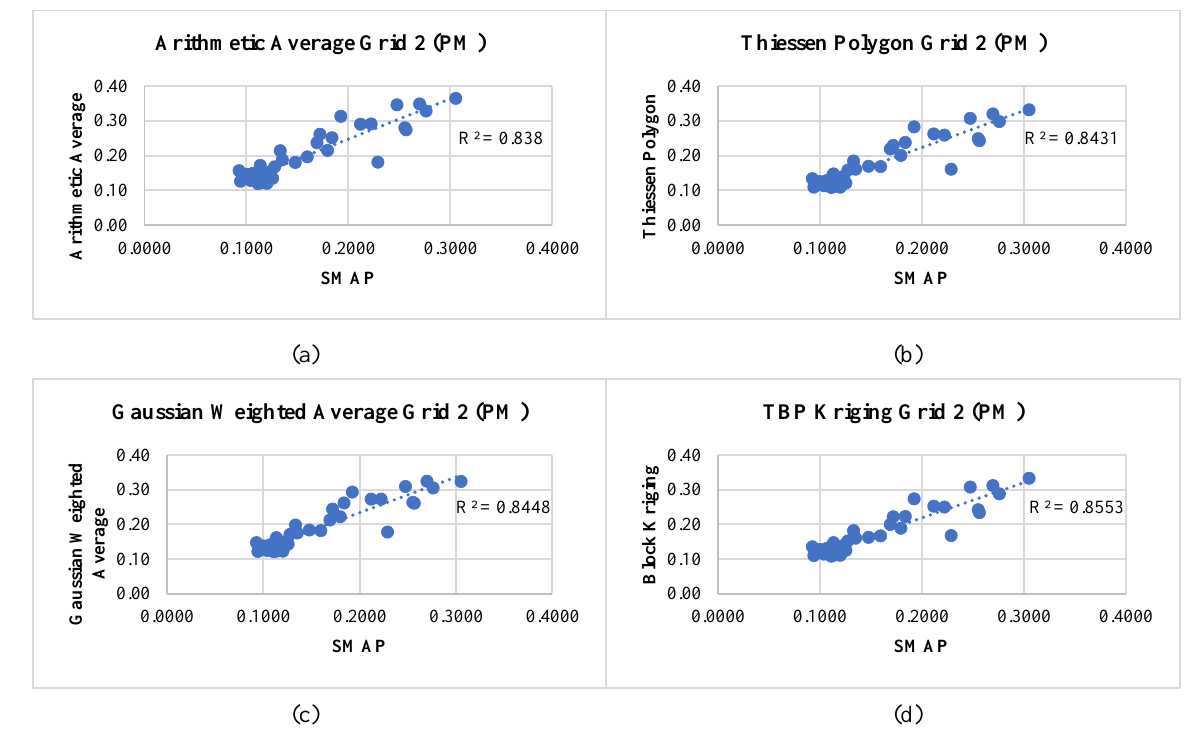
Figure 9. Grid 2 — spatial autocorrelation detected: correlation plot between the afternoon SMAP data and the four upscaling algorithms. ( a ) arithmetic average; ( b ) Thiessen polygon method; ( c ) Gaussian-weighted average; ( d ) TBP kriging. Table 3. Model Performance Comparison for the AM/PM Data for Grid